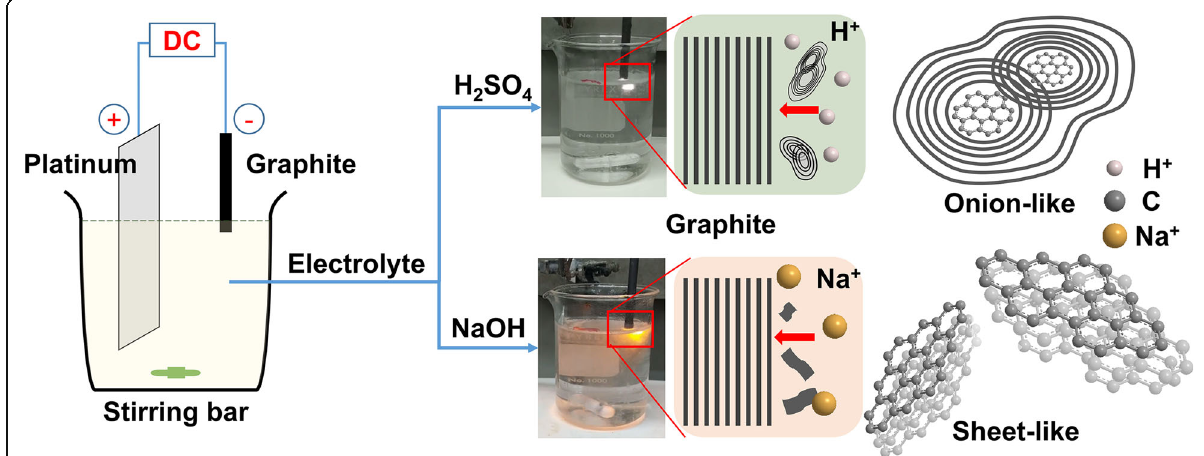
Fig. 1 Schematic representations of the experimental setup and the cathodic plasma exfoliation processes using NaOH and H 2 SO 4 as electrolytes, along with digital images of the